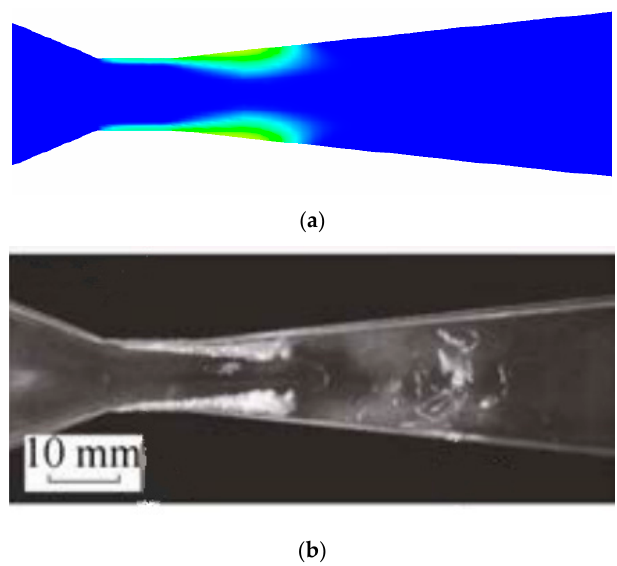
Figure 5. Comparison between simulated cavitation cloud and the experimental cavitation cloud obtained by Long et al. [30] with the inlet pressure of 400 kPa and the outlet pressure of 279 kPa, ( a ) simulated, ( b ), observed by Long et al. [30].